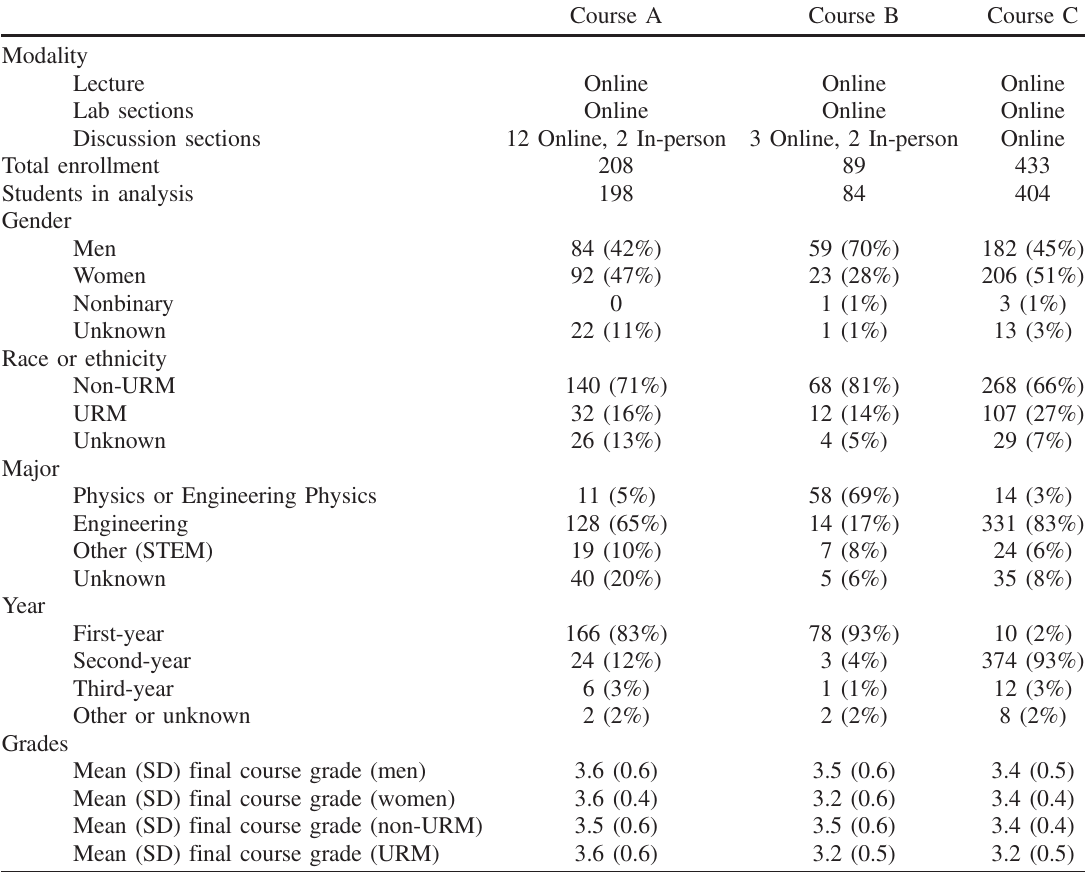
TABLE I. Summary of the modality, student demographics, and student final course grades for the three courses we analyzed. All online meetings were synchronous. Percentages are relative to the number of students included in the analysis. We denote students ’ gender or race or ethnicity as “ unknown ” if they preferred not to disclose this information on the survey or if they did not complete the survey (but did consent to other parts of the research). Grades are provided on a 4.0 scale, with standard deviations (SD) of the means given in parentheses.